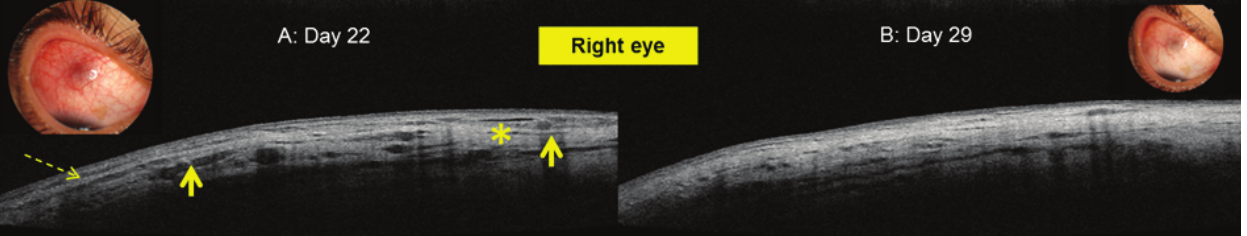
Figure 2. (A) Optical coherence tomography showed separated fibers (dashed arrow) and inflammatory infiltrates (solid arrow) due to recurrence of anterior scleritis in the right eye. (B) Resolution of signs in the final